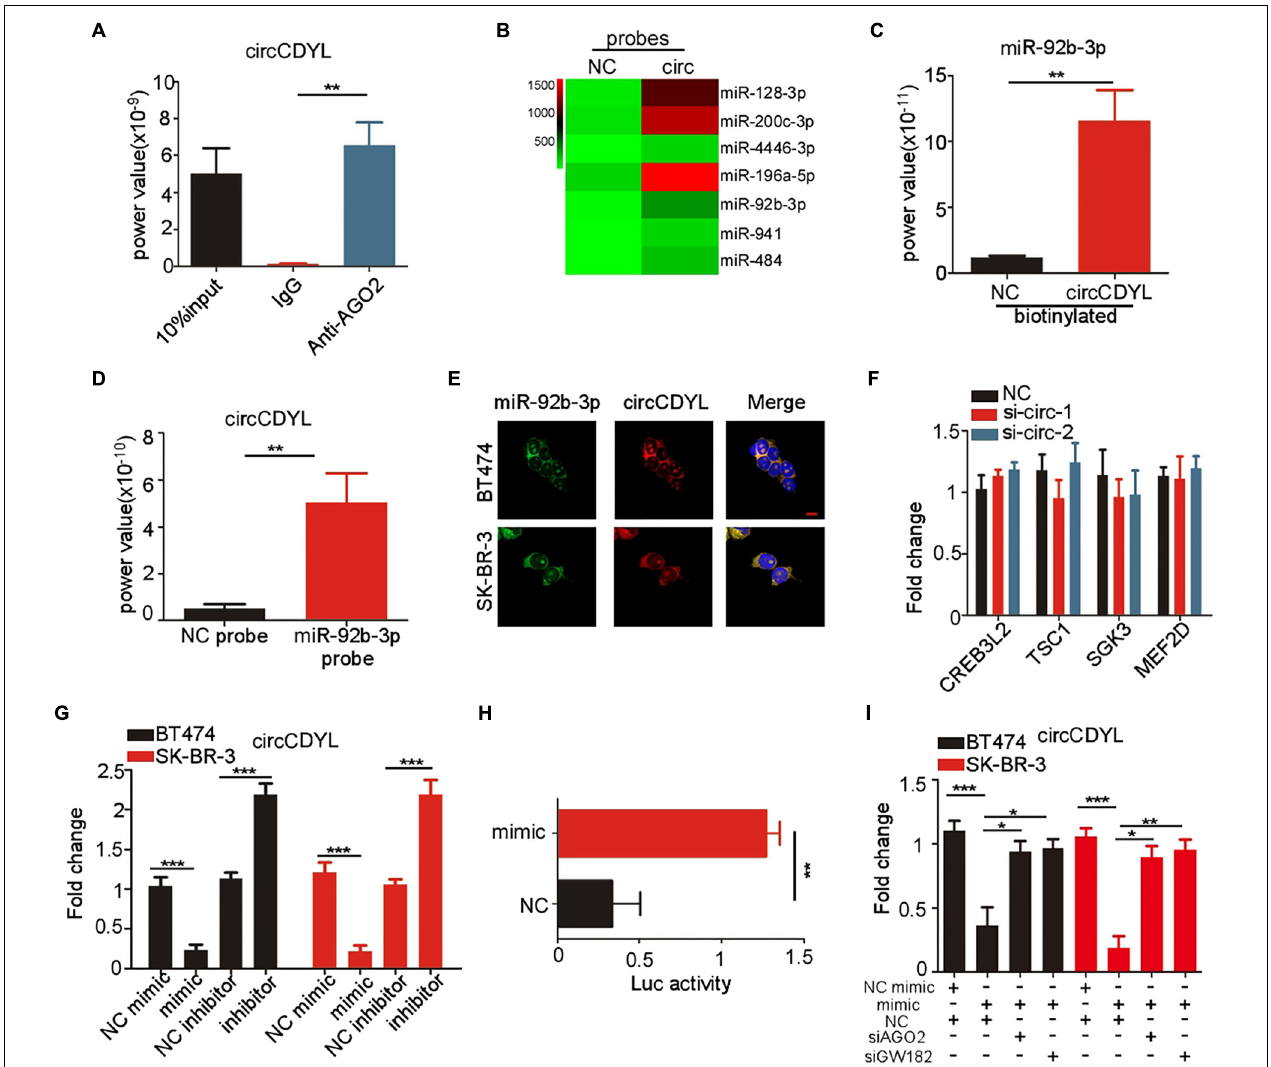
FIGURE 4 | circCDYL is degraded in miR-92b-3p-dependent RISC manner. (A) qRT-PCR detection of circCDYL in RNA sample pulled down by AGO2 antibody in RIP experiment. (B) MiRNA profile of RNA sample pulled down by circCDYL probes in circRNA pull-down assay, as detected by miRNA deep-sequencing. (C) qRT-PCR detection of miR-92b-3p in RNA sample pulled down by circCDYL probes in circRNA pull-down assay. (D) qRT-PCR detection of circCDYL in RNA sample pulled down by miR-92b-3p probes in miRNA pull-down assay. (E) FISH assay to detect the co-location of circCDYL and miR-92b-3p in BT474 and SK-BR-3 cells. (F) qRT-PCR detection of miR-92b-3p targeted genes (CREB3L2, TSC1, SGK3, and MEF2D) in SK-BR-3 cells after silencing circCDYL. (G) qRT-PCR detection of circCDYL in SK-BR-3 and BT474 cells after miR-92b-3p mimic or inhibitor transfection. (H) Dual luciferase assay in SK-BR-3 cells co-transfected with miR-92b-3p mimic and luciferase reporter plasmid (inserted with full length of circCDYL). (I) qRT-PCR detection of circCDYL in SK-BR-3 and BT474 cells after transfection of miR-92b-3p mimic or con-transfection of miR-92b-3p mimic and AGO2 or GW182 siRNA. All experiments above were repeated at least three times. * P < 0.05, ** P < 0.01, and *** P < 0.005. Error bars indicate